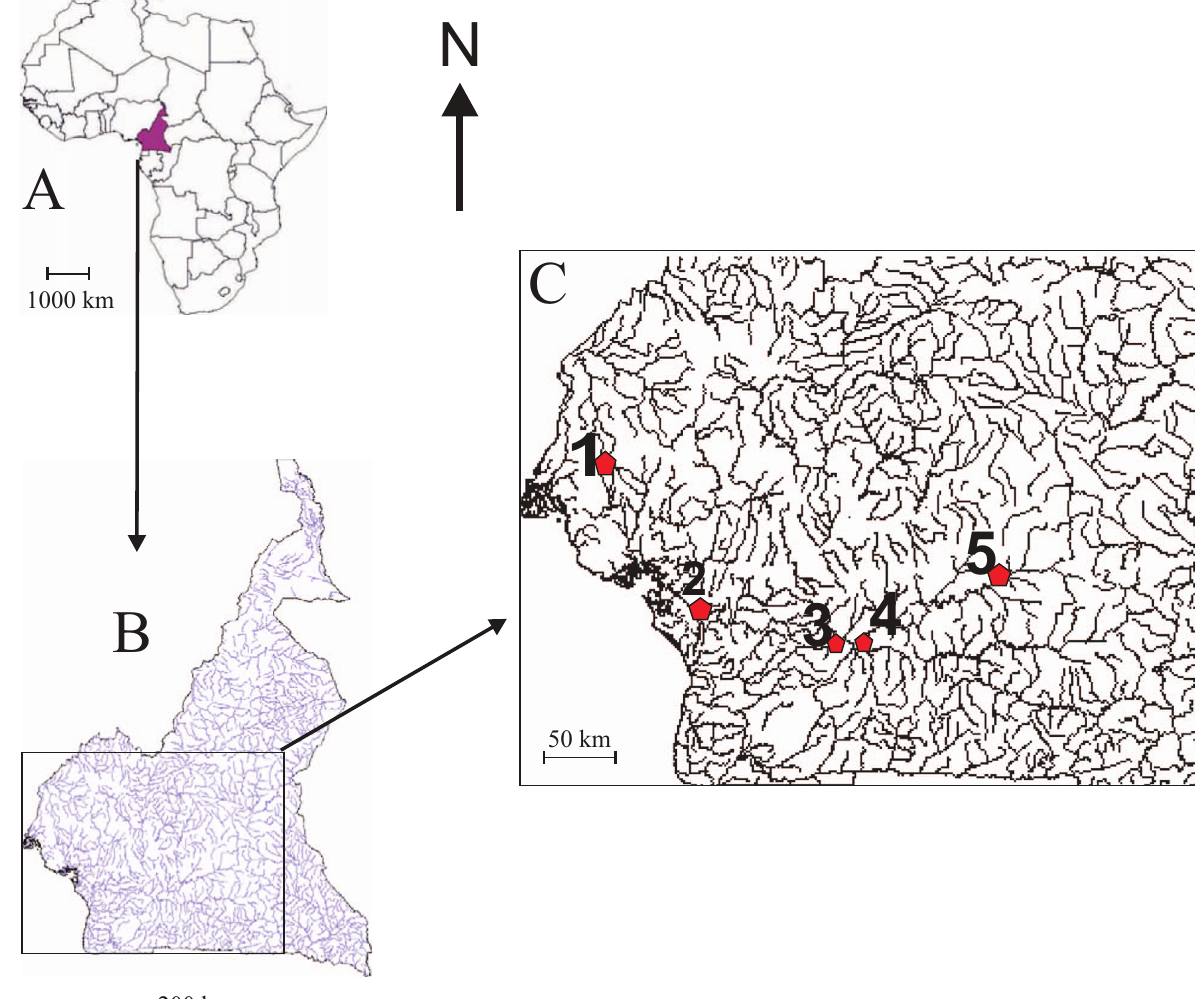
Figure 1. Sampling locations: (1) Lake Barombi Mbo; (2) Lake Ossa; (3, 4 & 5) Nyong River, (3) Mbalmayo market, (4) Mengong, (5) Abong Mbang. A = Africa, B = Cameroon, C = Studied